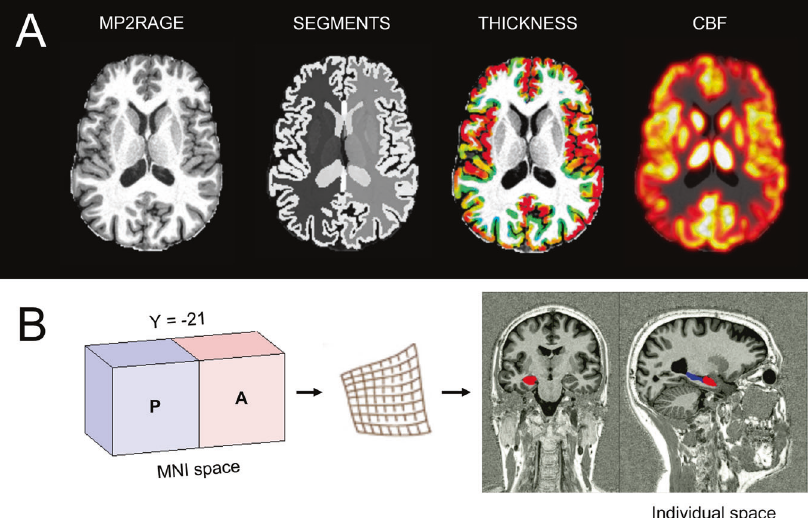
Fig. 1 Multimodal MRI measurements. A MRI measurements in volume (segments), cortical thickness, and CBF. B Segmentation of anterior ( A ) and posterior ( B ) subparts of the